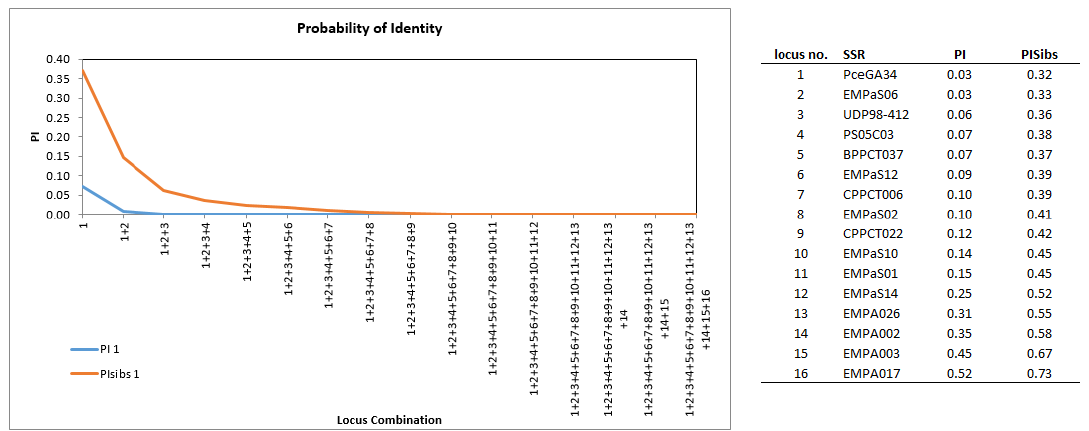
Figure 2. The probability of identity ( PI ) and the PI sib (taking into account related individuals in the cherry collection), based on the diminished PI value of each locus. Evaluation based on the analysis of 383 unique sweet cherry genotypes using 16 SSR. PI = Probability of Identity (2 * [Sum (pi ^2)^2]- Sum(pi)^4); PI sibs = Probability of Identity for Sibs at a Locus = 0.25 + [0.5 * Sum(pi^2) ] + [0.5 * Sum(pi^2)^2] − [0.25 *